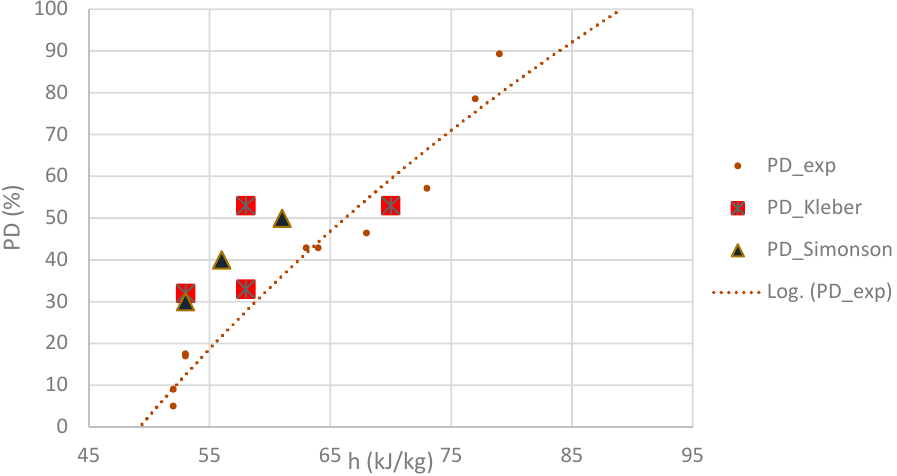
Figure 8. Comparison of the experimental results of indoor discomfort perception (log.PD_exp) with the former research presented by Kleber ( PD _Kleber ) [28] and Simonson ( PD _Simonson ) [40].